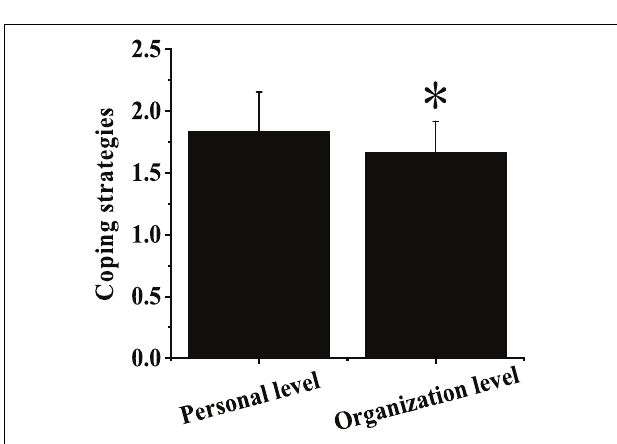
FIGURE 2 | Descriptive statistics of stress-coping strategies of employees. ∗ Indicated that the difference was notable compared with the individual level ( P < 0.05).